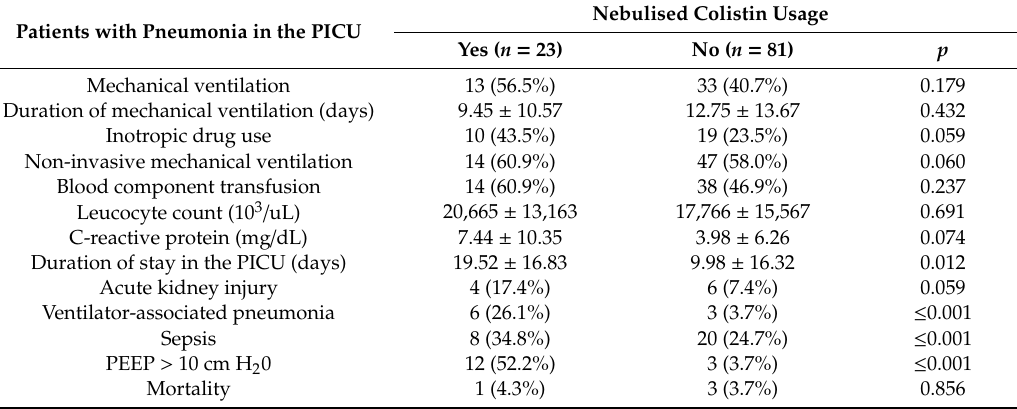
Table 5. Analysis of factors associated with adverse outcomes in patients with pneumonia with or without nebulised colistin